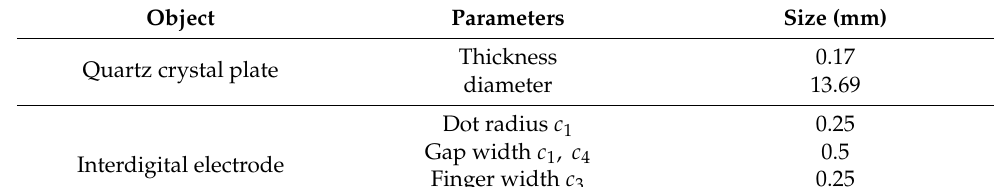
Table 1. Dimensions of quartz crystal and double-finger electrode.